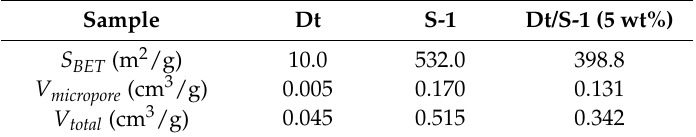
Table 1. Porous parameters of Dt, S-1 and Dt/S-1 (5 wt%). S BET = specific surface area. V micropore = micropore volume. V total = total volume.